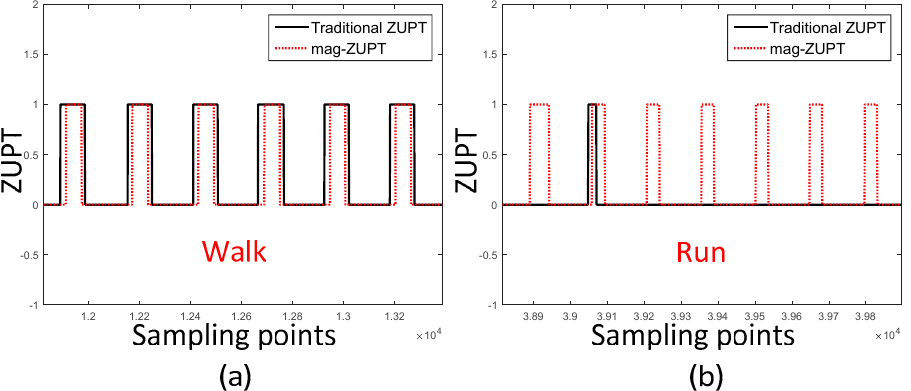
Figure 15. Traditional ZUPT and mag-ZUPT results in walking and running gait patterns; ( a ) is the walking scenario. The two ZUPT detectors have a similar performance; ( b ) is the running scenario. Seven stance phases are correctly detected by mag-ZUPT while only one stance phase is detected by traditional ZUPT.